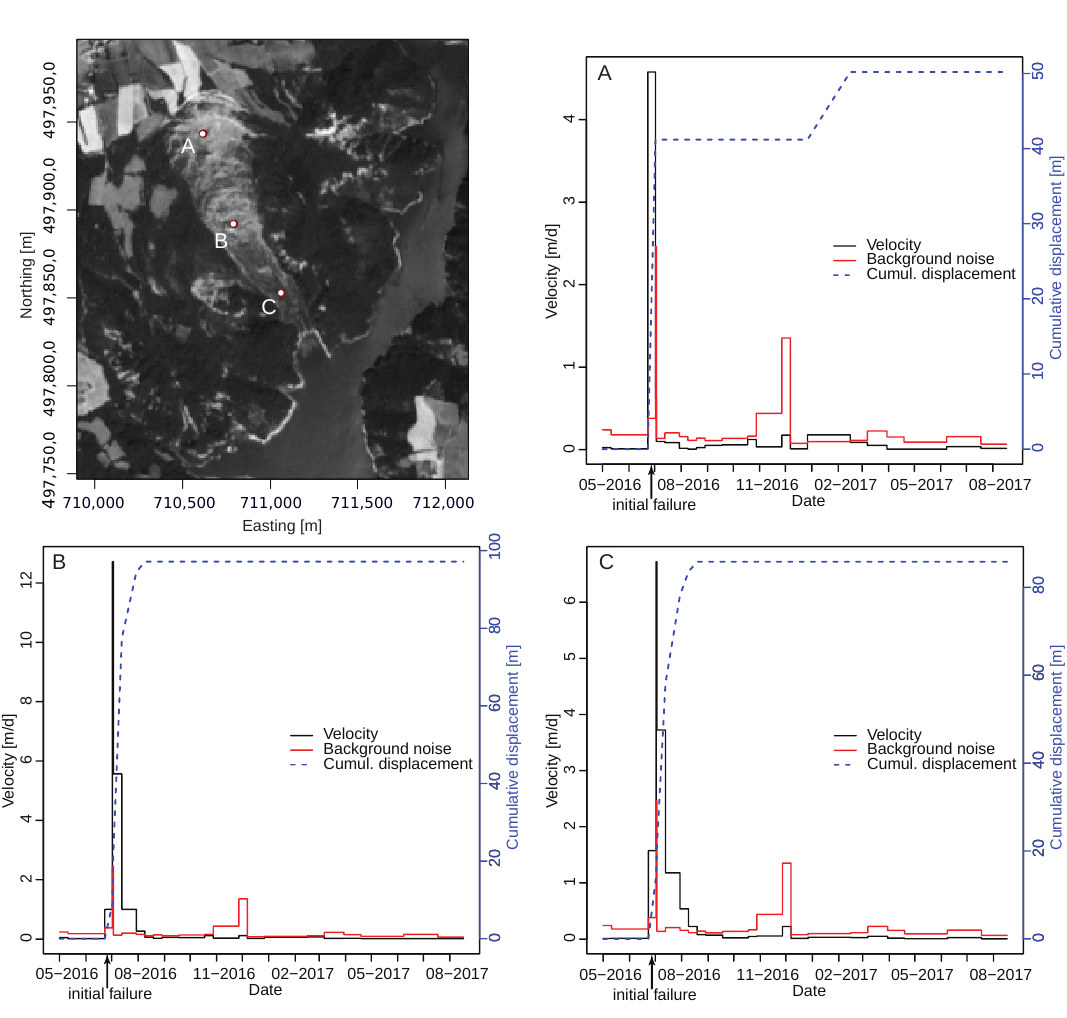
Figure 8. Surface motion time-series for the Harmalière landslide from 5 May 2016 to 21 August 2017 at three selected points at ( A ) the head scarp, ( B ) the transport zone and ( C ) the toe. The figures show the measured velocities in relation to the background noise (95% quantile). Only measurements exceeding the respective background noise are taken into account to compute the cumulative